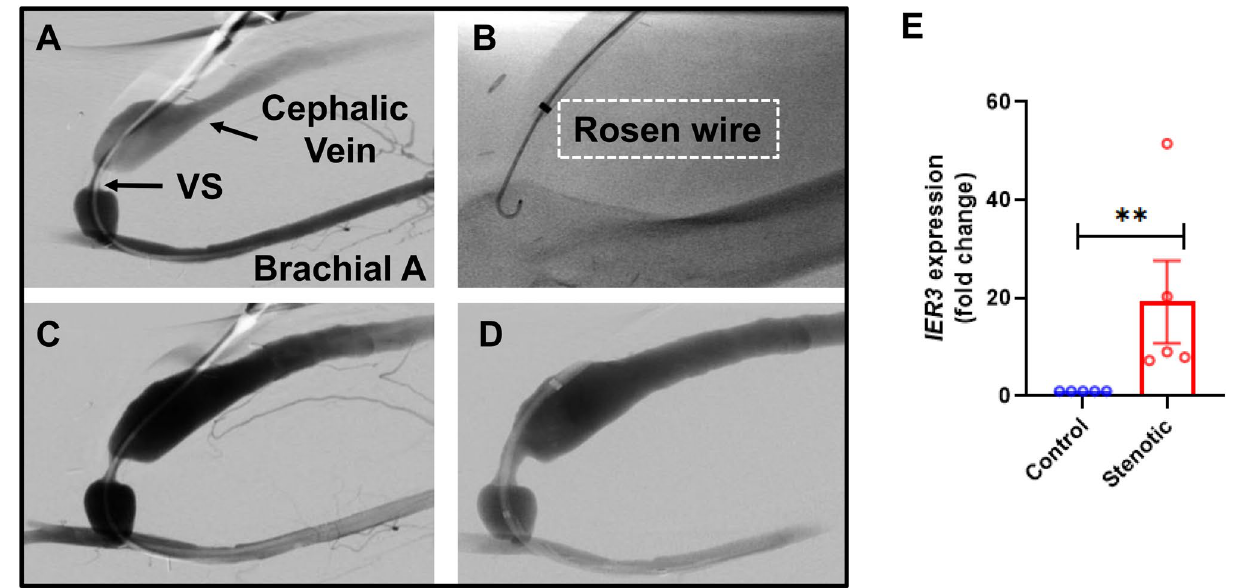
Figure 1. Increased Ier3 gene expression in stenotic hemodialysis vascular access. ( A ) Representative angiogram showing stenosis at the anastomosis of the brachial artery to cephalic vein. ( B ) The insertion of Rosen wire across stenosis to sample the stenosis. ( C ) Angiogram of the stenosis after venous sampling. ( D ) Angiogram of the stenosis after angioplasty. ( E ) There is a significant increase in the average gene expression of Ier3 of stenotic AVFs compared to controls. Each data point in the scatter plot bar graph represents the mean ± SEM of 5 patients. Mann Whitney test was performed. Significant differences between groups are indicated * p <